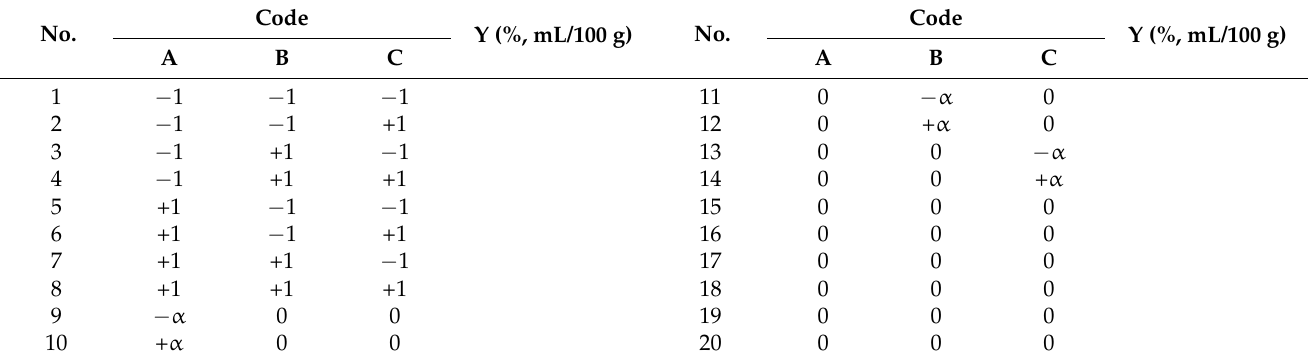
Table 1. Experimental design table with three factors according to CCD of